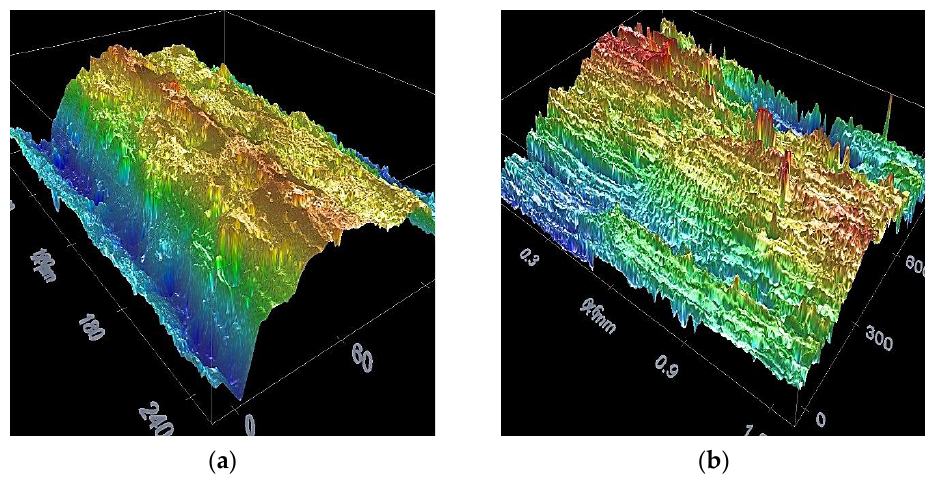
Figure 4. Confocal observation: longitudinal section, ( a ) exterior and ( b ) interior of the Diss fiber.